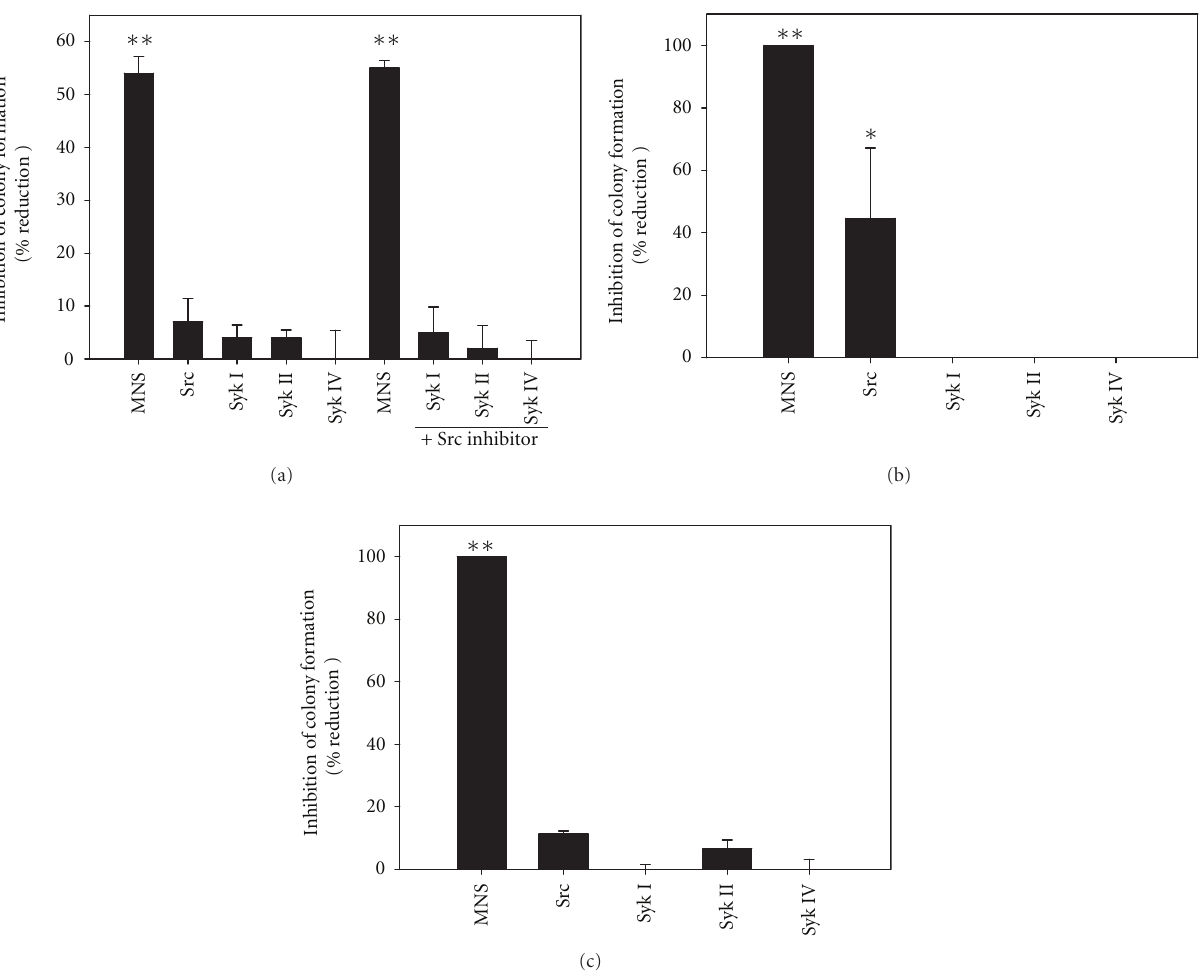
Figure 8: Specific tyrosine kinase inhibitors of syk and src do not reduce motility or colony formation by the metastatic 143B cells (panel (a) & (b)) or colony formation by the non-tumorigenic/non-metastatic TE85 cells (panel (c)). Motility and colony formation assays were performed in the presence of tyrosine kinase inhibitors or 1% DMSO as a vehicle control. Bars represent the means ± standard error of the mean of three individual experiments (scrape motility assays with four to six scrapes per group; colony formation assays with three wells per group). Double asterisks denote P < 0 . 001 compared with the vehicle control groups; single asterisk (panel (b)) denotes P = 0 . 012. of telomerase which prevents telomere erosion during repeated cell cycles [9, 45]. Telomerase e ff ectively prevents cell senescence and prolongs the life of tumor cells [9,